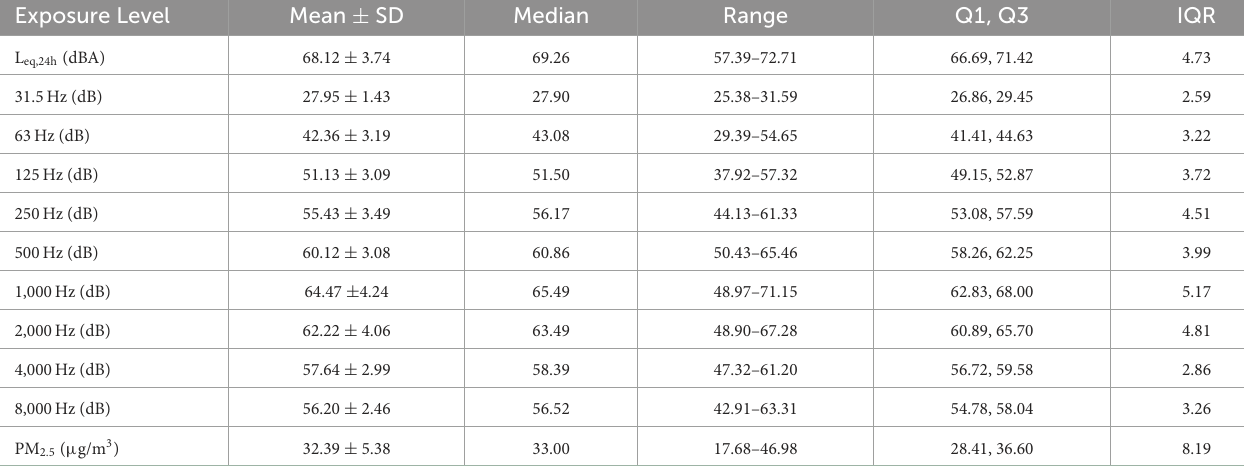
TABLE 2 Distributions of annual 24-h road traffic noise and fine